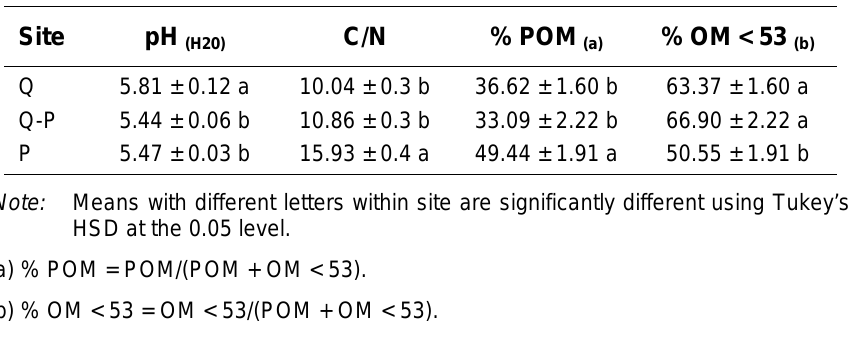
A-Horizon Characteristics (0–15 cm) of Investigated Sites in Valsaín